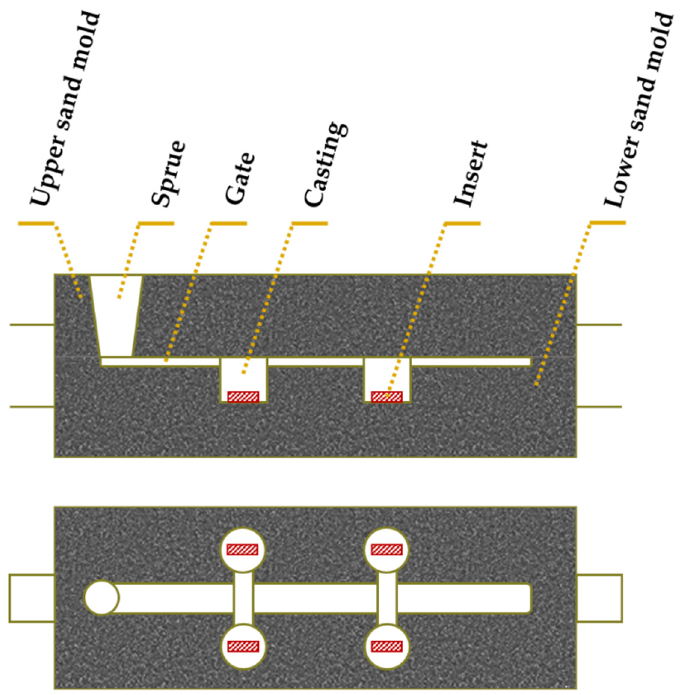
Figure 3. Scheme of the mold with the Fe–WC inserts (side and top views) (adapted from [40]).